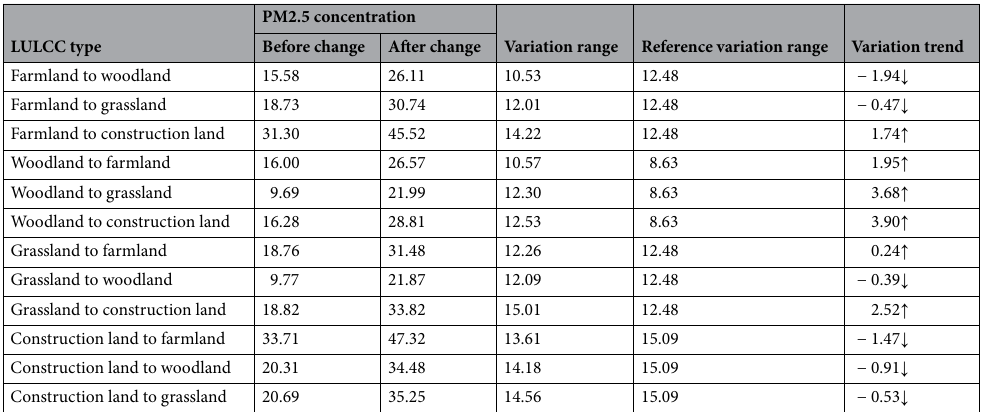
Table 5. Dynamic PM 2.5 concentrations in the LULCC areas (units: μg/m 3 ).